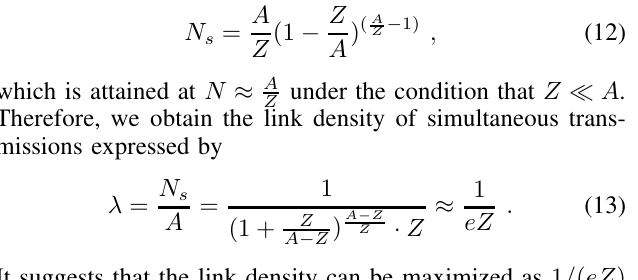
Note that any carrier sensing threshold can be indicated